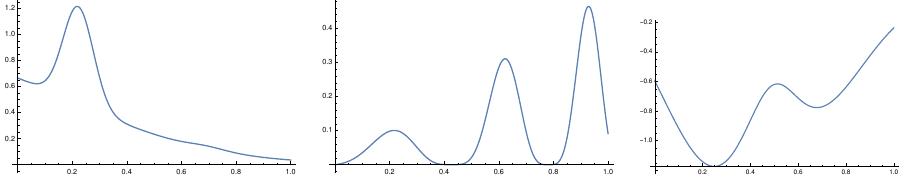
Figure 2. Plots of test functions: f 1 ( left ), f 2 ( center ) and f 3 ( right ).